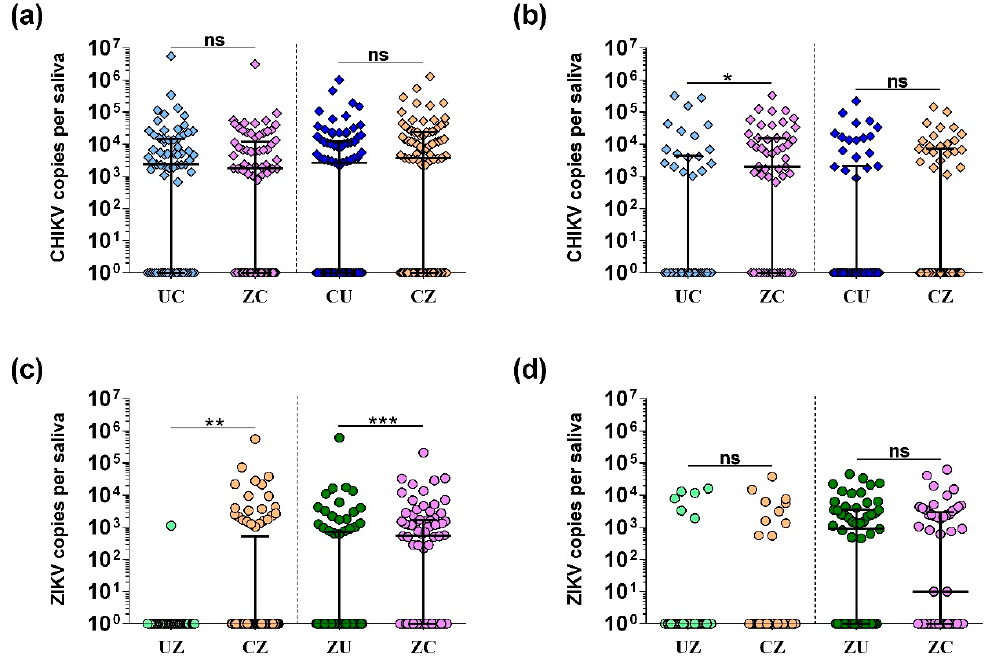
Figure 3. Viral RNA copy numbers in the saliva of single and dual infected Ae. aegypti mosquitoes. CHIKV copy numbers in mosquito saliva are shown for ( a ) 7 dpi and ( b ) 12 dpi. ZIKV copy numbers in mosquito saliva are shown for ( c ) 7 dpi and ( d ) 12 dpi. All viral copy numbers were quantified using qRT-PCR and are shown combined from three replicate experiments. The median, including zero values log10(x + 1) transformed, is indicated, and error bars show the interquartile range. ANOVA was used to determine statistical significance as indicated (* p < 0.05; ** p < 0.01; and *** p < 0.001), taking replicates into account.